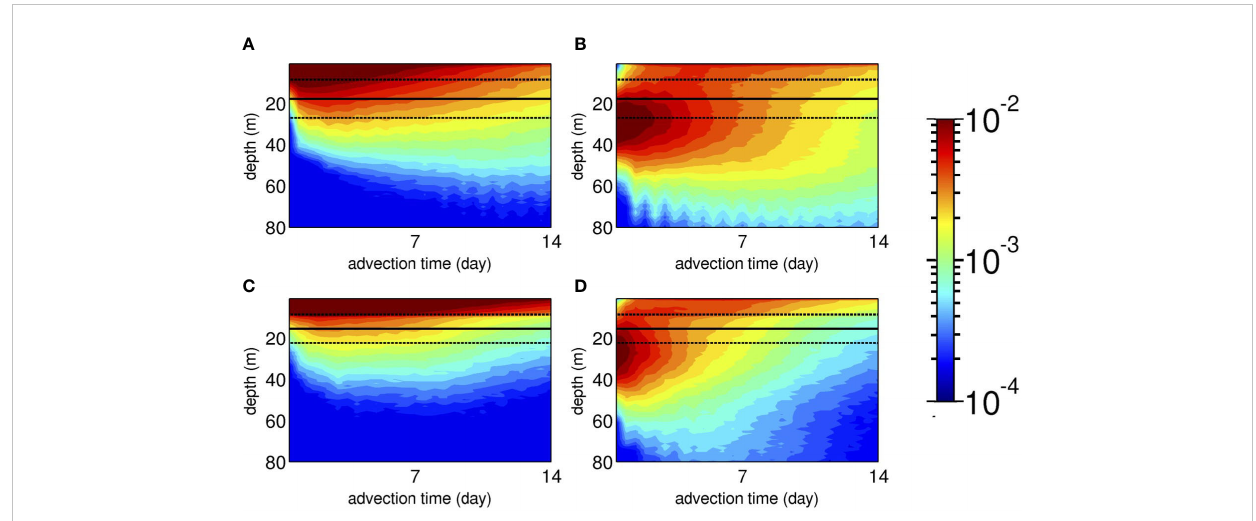
in Figure 8. Strikingly, the mixed layer constrains the vertical extent of the virtual larvae. For the larvae released from a 2 m depth (Case 1, Figures 8A, C), most of the larvae stay above the base of the mixed layer at approximately – 18< z ≤ – 23 (m), which reduces the number of near-surface larvae that sink. As a result, in both areas, the Lagrangian PDFs near the surface are ~10 -2 , while they are lowered to ~10 – 3 at ~40 m, which is one order of magnitude smaller. Near- surface retention is more apparent with less downward dispersion in area B than in area A because of extensive shallow nearshore areas in